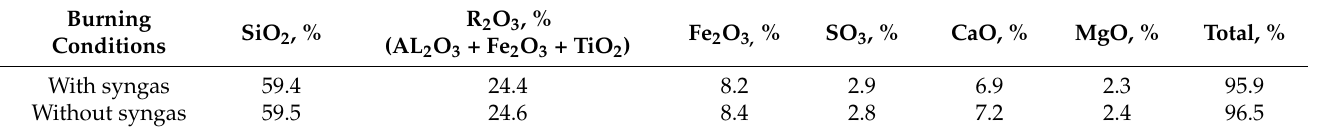
Table 3. Ash residue component composition.